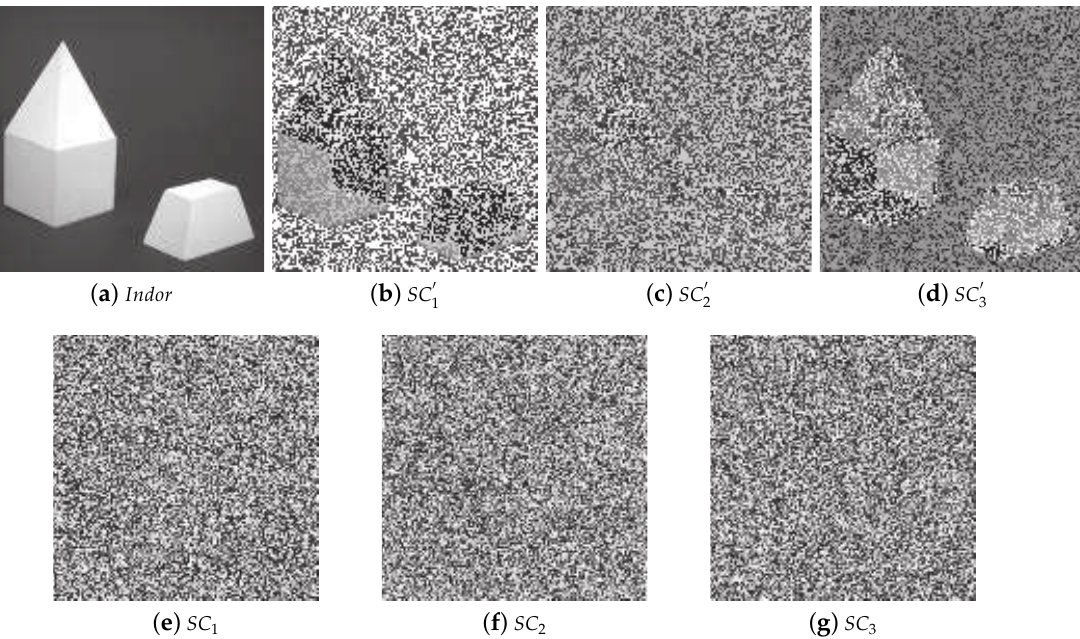
Figure 9. Comparisons of generated shadows between Yan et al.’s and our ( 2,3 ) threshold SIS. ( a ) The grayscale secret image Indor ; ( b – d ) three grayscale shadows SC (cid:48) al.’s scheme; ( e – g ) three grayscale shadows SC 1 , SC 2 and SC 3 gernerated by our